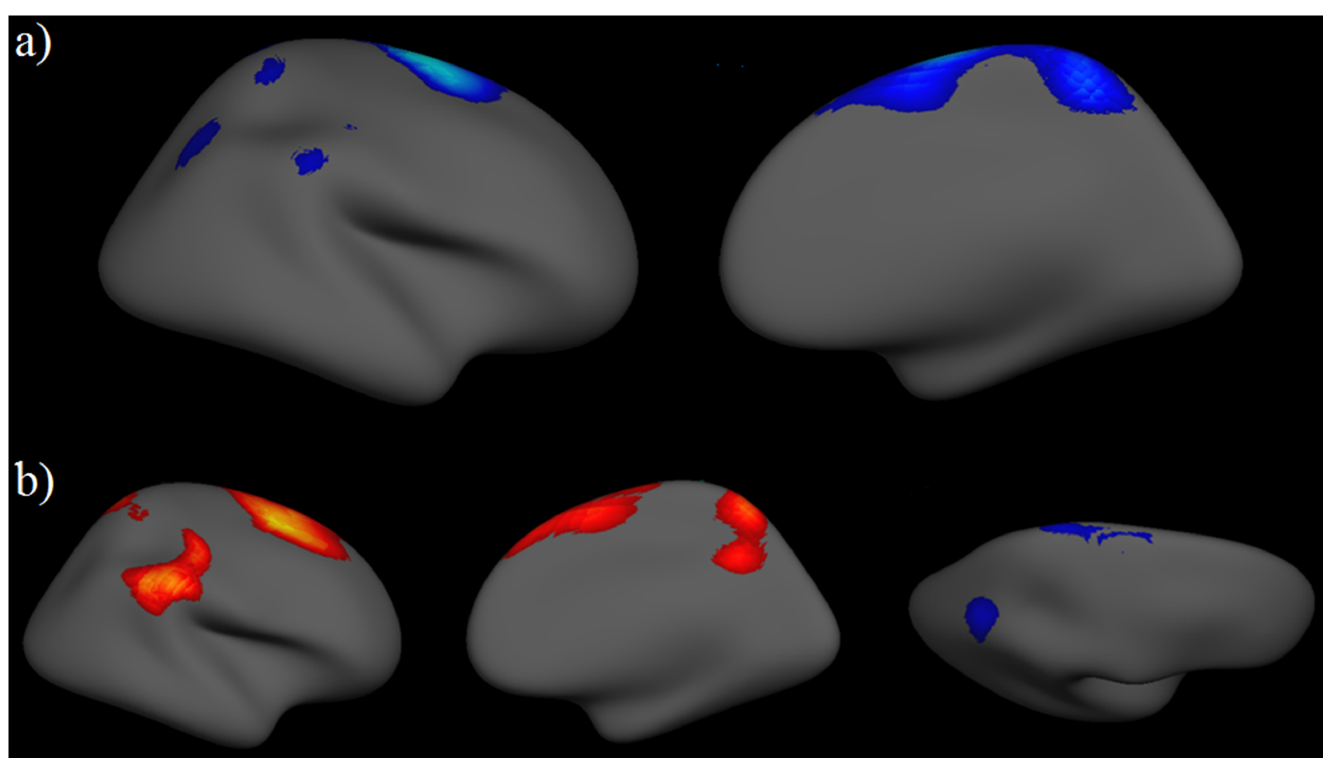
Fig 1. Association between mother aggressive behavior and brain development. a) Mother aggressive behavior by age by sex interactions for right hemisphere cortical thickness (FDR corrected, p < 0.05), and b) mother aggressive behavior by age interactions for male cortical thickness (left two images, FDR corrected, p < 0.05), and for female cortical thickness (right image, uncorrected, p < 0.001).